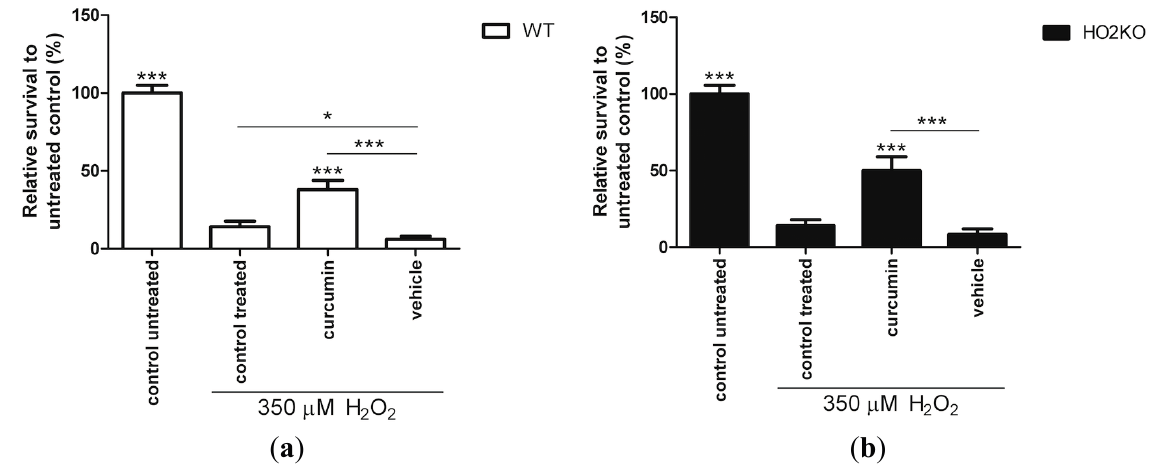
Figure 4. Curcumin treatment rescues WT and HO-2 KO ASCs against H 2 O 2 -induced cell death. ( a ) WT ASC and ( b ) HO-2 KO ASC survival after 24 h pre-treatment with curcumin, vehicle control, or untreated (control) and 24 h co-treatment together with 350 µM H 2 O 2 following an Alamar blue assay and fluorimetric quantification, related to untreated control. Vehicle consisted of 0.5% ethanol (curcumin solvent) in culture media. * is significant different from H 2 O 2 -treated control. ( * p < 0.05, *** p < 0.001). Data